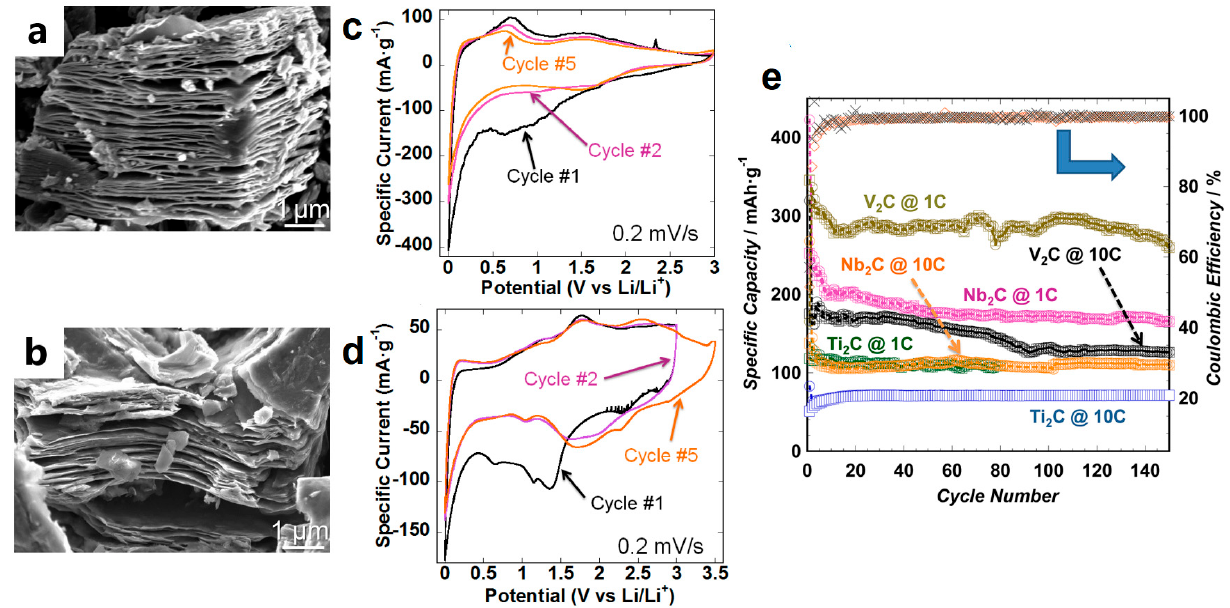
Figure 5. ( a ) SEM images of Nb 2 CT x powder; ( b ) SEM images of V 2 CT x powder; ( c ) Cyclic voltam- mograms for Nb 2 CT x ; ( d ) Cyclic voltammograms for V 2 CT x ; ( e ) Specific capacities vs cycle number at different rates for Nb 2 CT x and V 2 CT x − based electrodes. Reprinted with permission from [30]. Cop- yright © 2013, American Chemical Society.